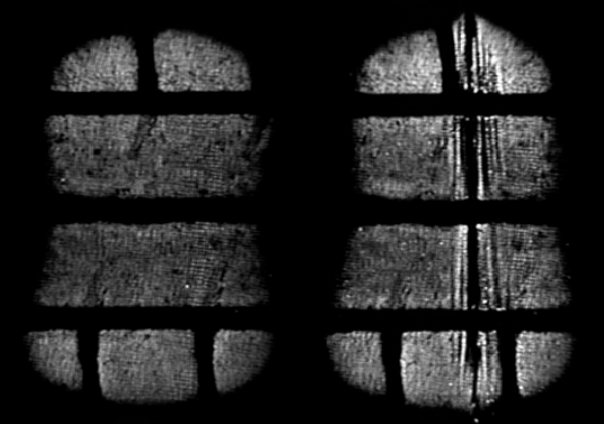
Figure 23. Grey levels in the contact patch: before the defect ( left ); and after the defect ( right ).